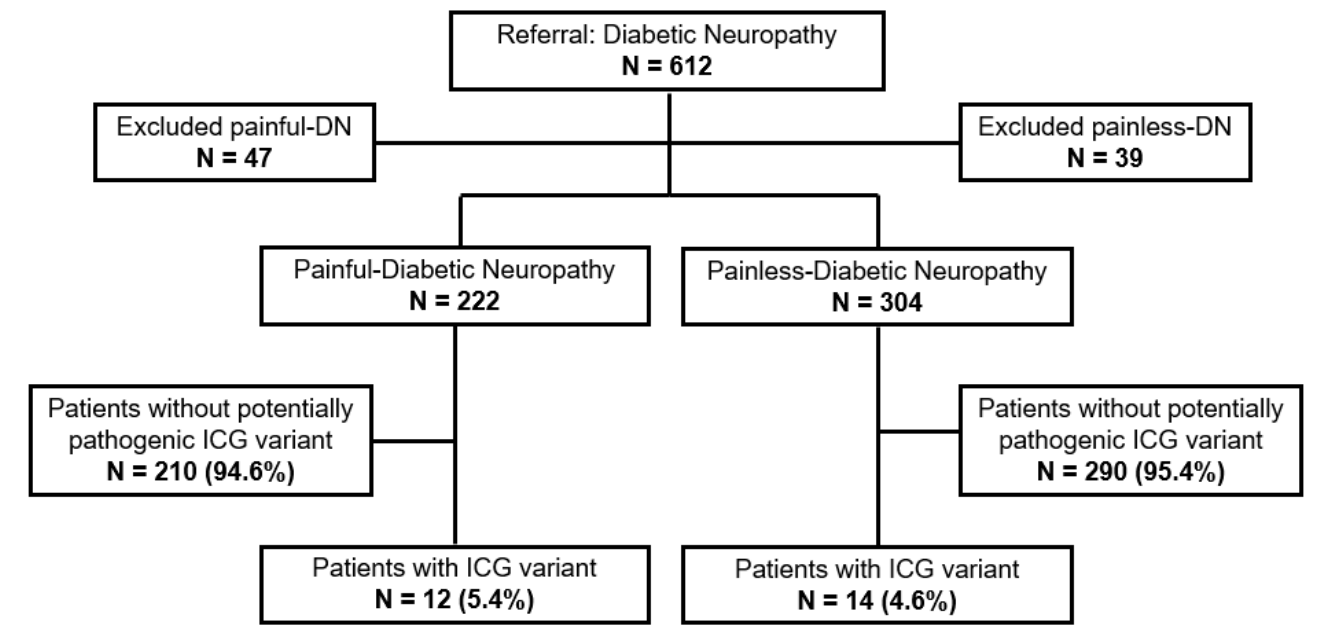
Figure 1. Patients with painful- and painless-diabetic neuropathy screened for potentially pathogenic variants in 15 ion channel gene panel. ICG, Ion Channel Gene; DN, Diabetic Peripheral Neuropathy; N, number. Table 1. Potentially pathogenic variants of ion channel genes identified in patients with painful- diabetic neuropathy ( n = 222).